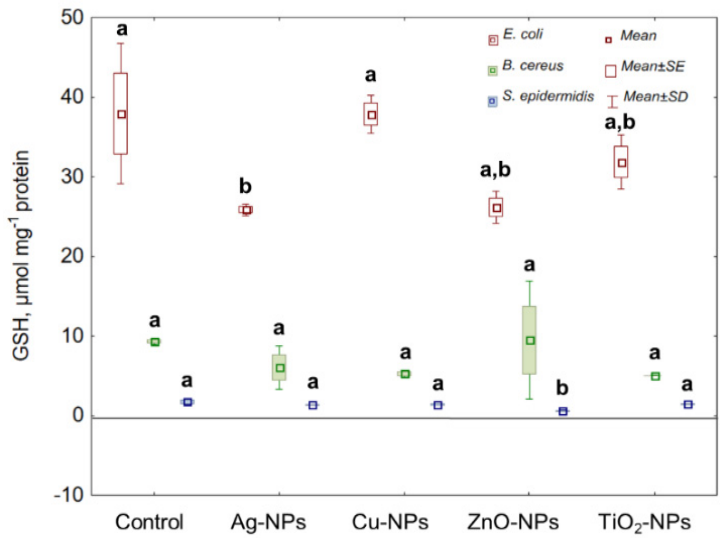
Figure 3. The GSH concentration in E. coli , B. cereus and S. epidermidis exposed to NPs at an IC 50 value (mean ± SD/SE; n = 3). Means with the same letter(s) are not significant at p < 0.05 between the control and NPs-treated cells. the control and NPs-treated